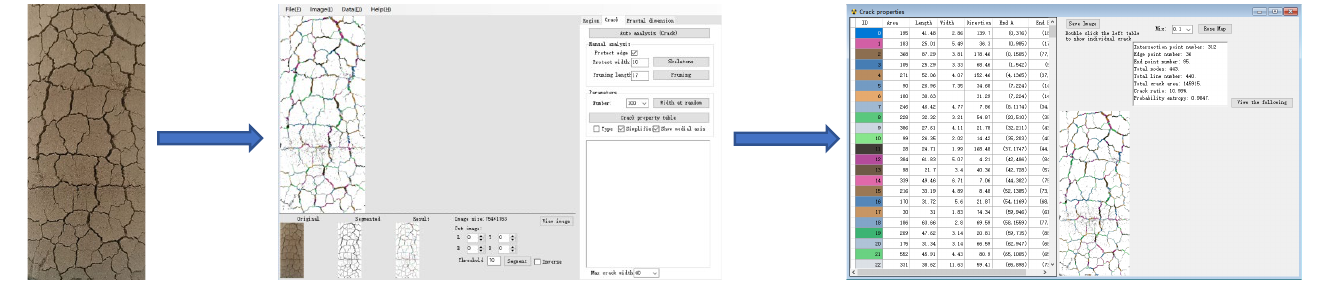
Figure 2. The quantification of the crack image (PCAS).